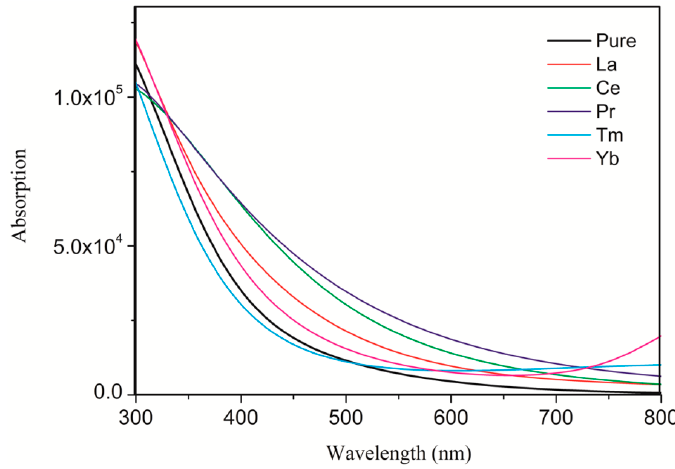
Figure 4. Calculated UV–visible absorption spectra of the pure and differently doped systems.